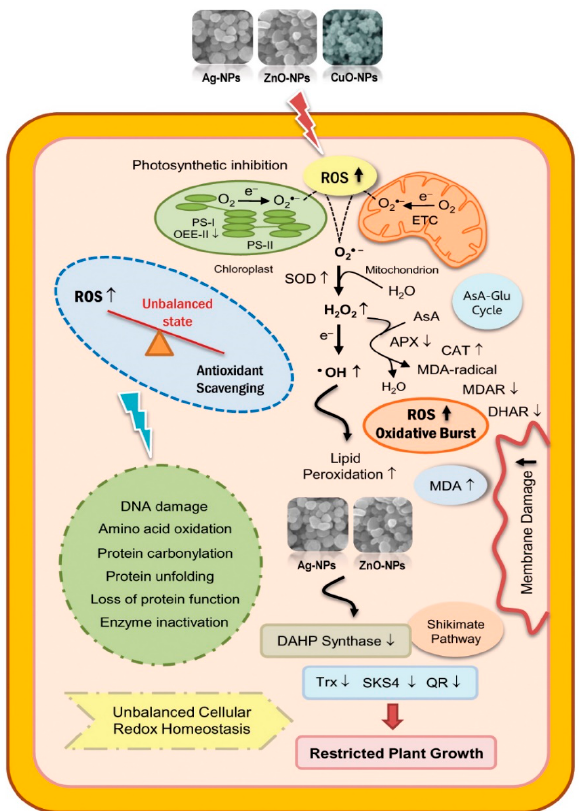
Figure 1. Schematic illustration of diverse cellular responses to nanoparticles (NPs). Exposure to metal based-NPs triggers oxidative stress through enhanced reactive oxygen species (ROS) generation, disruption of redox homeostasis, impaired photosynthetic activity, mitochondrial dysfunction, lipid peroxidation, and membrane damage. Upward arrows indicate increased and downward arrows indicate decreased protein abundance in response to NPs stress, respectively. Abbreviations: APX,ascorbate peroxidase; AsA, reduced ascorbate; CAT, catalase; DAHP, 3-deoxy-D-arabino-heptulosonate-7-phosphate; DHAR, dehydroascorbate reductase; ETC, electron transport chain; H 2 O 2 , hydrogen peroxide; MDA, malondialdehyde; MDA-radical, monodehydroascorbate radical; MDAR, monodehydroascorbate reductase; • OH, hydroxyl radical; OEE, oxygen-evolving enhancer; PS, photosystem; QR, quinone reductase; ROS, reactive oxygen species; SOD, superoxide dismutase; Trx,